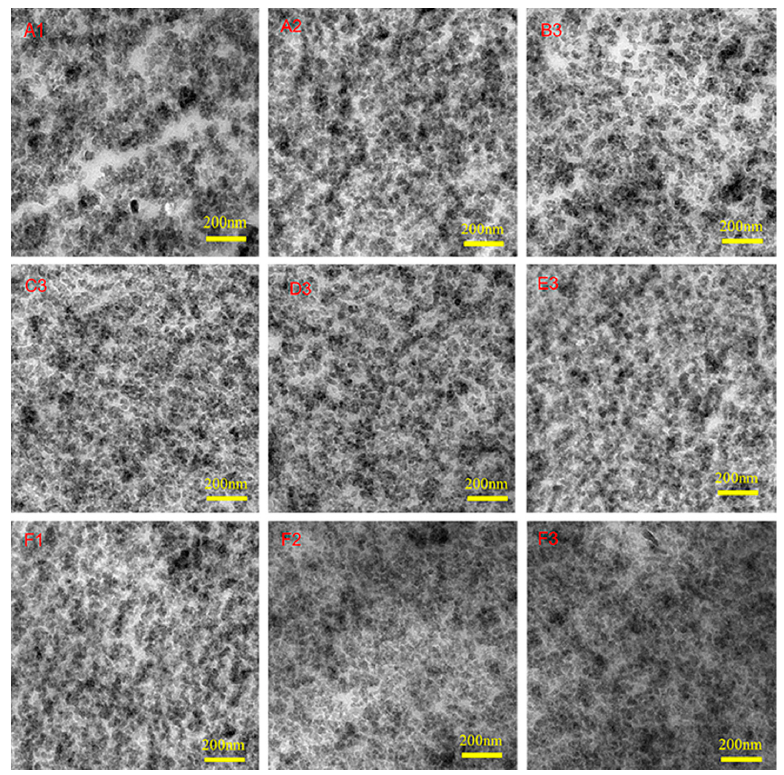
Figure 5. TEM images of PS-SSBR/BR( A1 ), TS-SSBR/BR( A2 ), E7-SSBR/BR( B3 ), E10-SSBR/BR( C3 ), E15-SSBR/BR( D3 ), E20-SSBR/BR( E3 ), E25a-SSBR/BR( F1 ), E25b-SSBR/BR( F2 ) and E25c-SSBR/BR( F3 ).